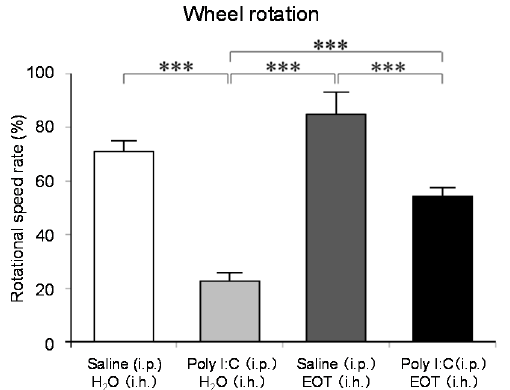
Figure 7. The effects of thyme on mouse activity. A brain fatigue model was prepared by intraperi-